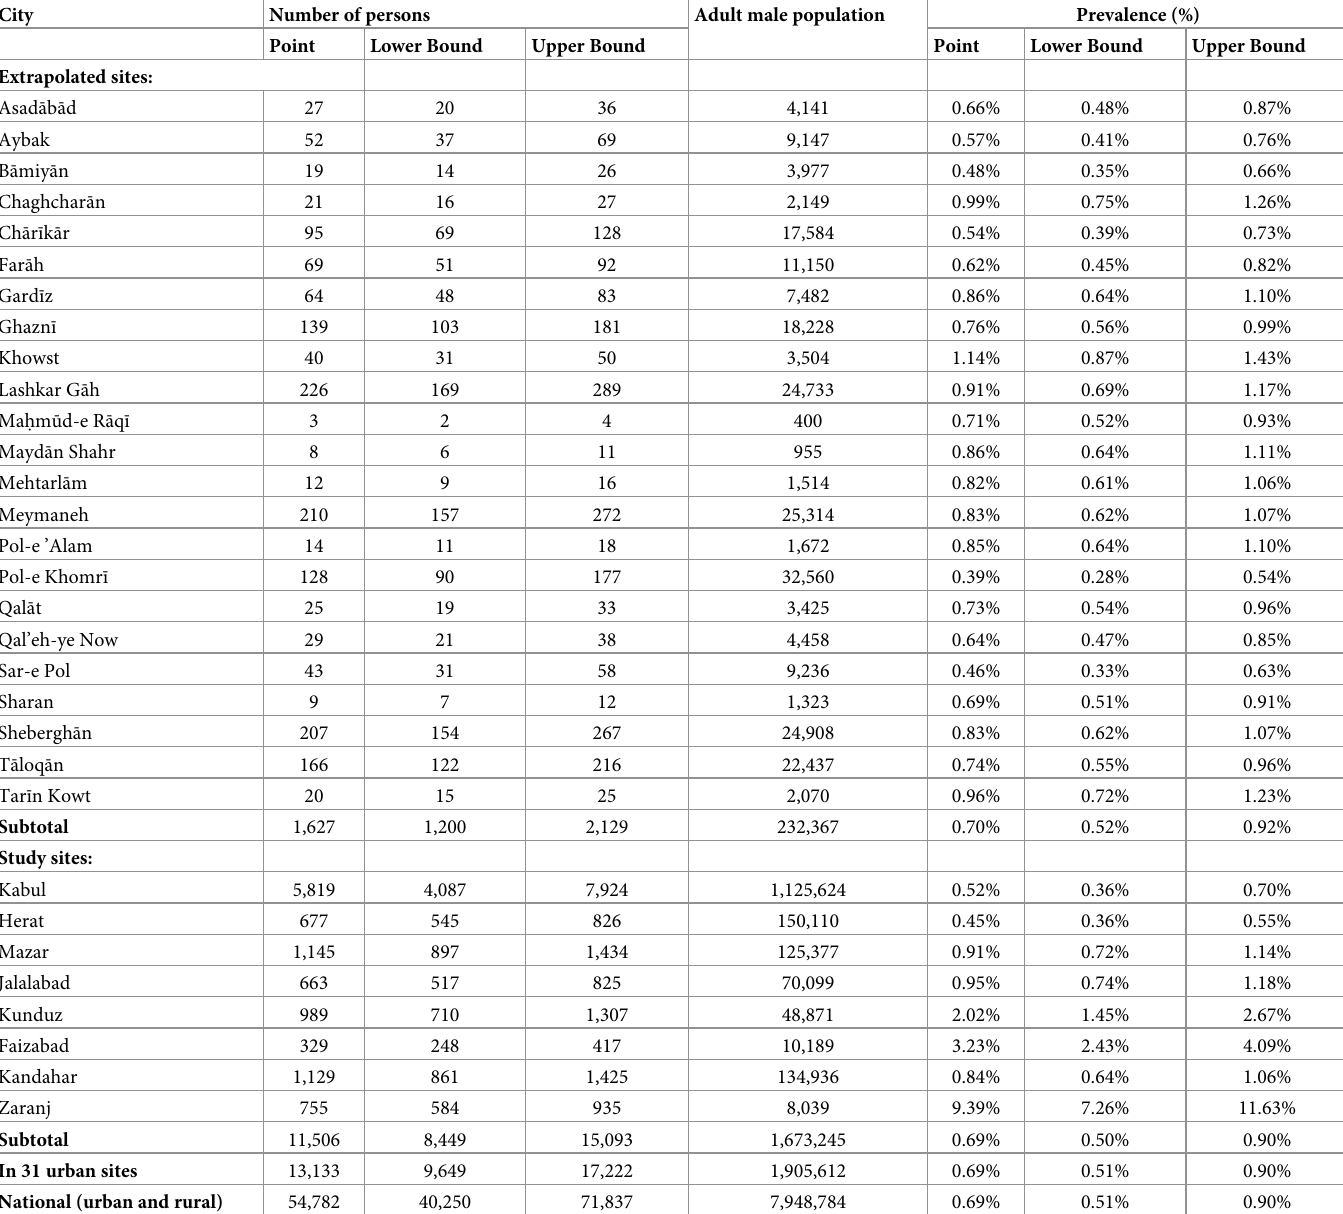
Table 8. Extrapolated population size and prevalence estimates for male people who inject drugs (PWID) in the adult male population (15–64 years old) in major cities in Afghanistan, and at the national level in 2019 (adjusted for winter seasonality